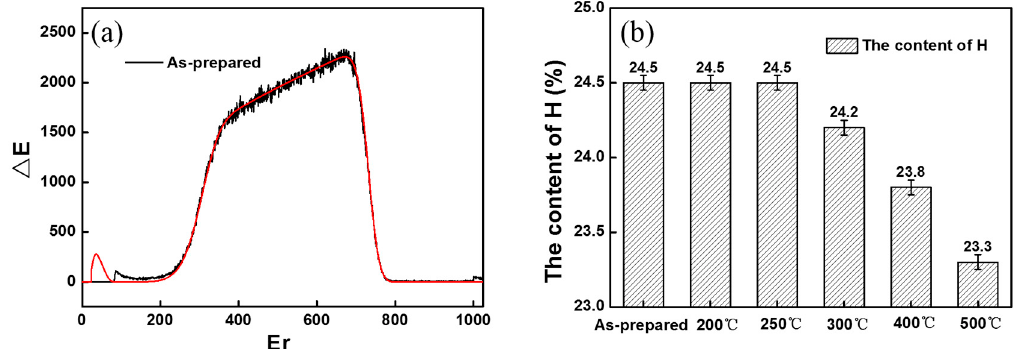
Figure 1. ( a ) Energy spectrum of the H component of FL-C:H films under different annealing conditions, ( b ) the content of H of FL-C:H films under different annealing conditions.